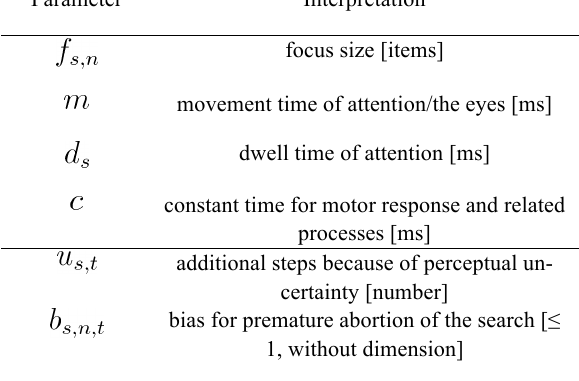
Figure 10. Schematic illustration of an hypothetical search course with focus size 3 according to STRAVIS (left panels) and STRAVIS 2.0 (right panels) The dark grey item depicts the target. The model parameters m , d and c represent the times for attentional movement, atten- tional dwell, and constant processes like motor response, dependent on the target-distractor-similarity s ( s = 1, 2, 3, 4) and the set size n ( n = 4, 6, 8). Model parameters in STRAVIS and STRAVIS